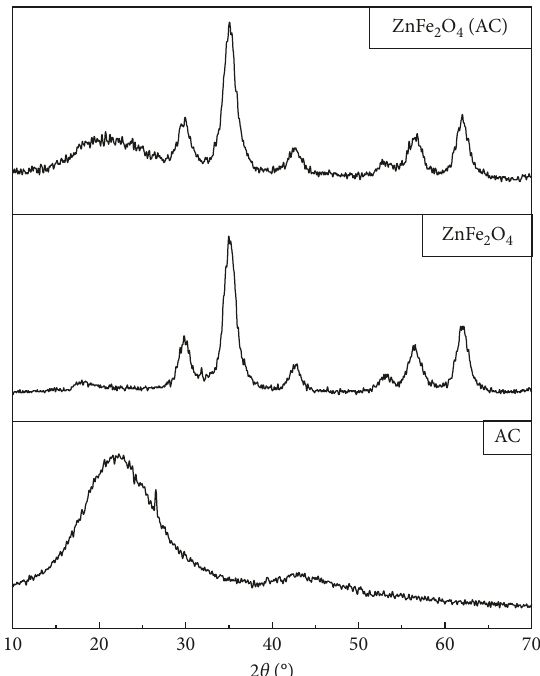
Figure 9: XRD patterns of (a) activated carbon, (b) ZnFe